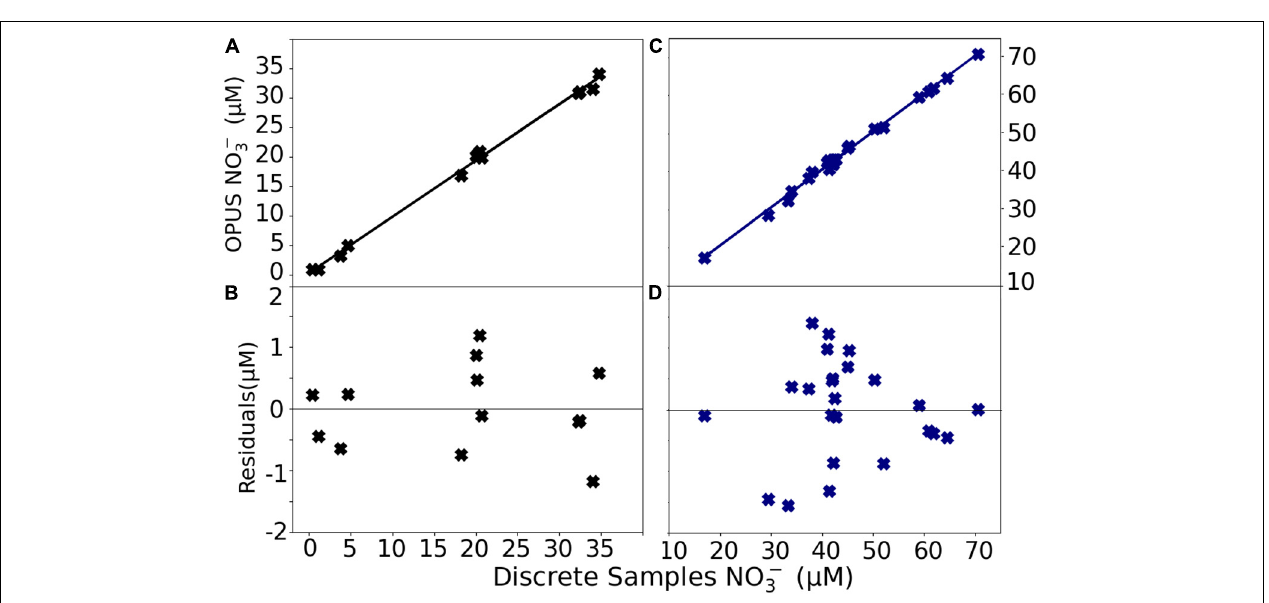
FIGURE 17 | Regression plots of NO 3 − concentrations determined in situ with the OPUS sensor vs. in the laboratory via autoanalyzer and residuals of the regression for the M158 data ( A,B , see also Figure 14 ) and Sternfahrt-1 data ( C,D , Figure 12